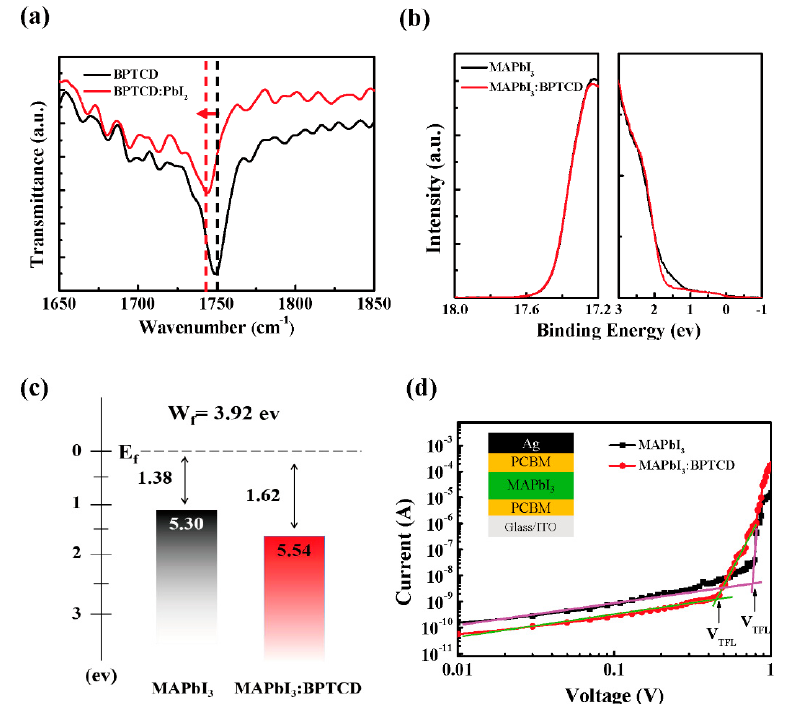
Figure 4. ( a ) FTIR spectra of pure BPTCD film and PbI 2 added BPTCD film ( b ) UPS results and ( c ) Energy level diagram of perovskite films with 3 wt.% and without BPTCD additive ( d ) I-V characteristic of an electron-only device based on perovskite film with 3 wt.% BPTCD, with an inset showing the device structure.